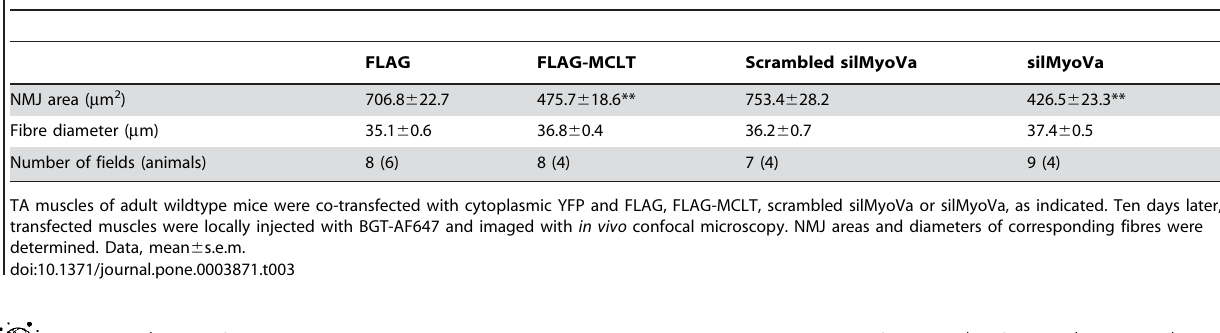
Table 3. Average NMJ areas and fibre diameters upon functional impairment of myosin